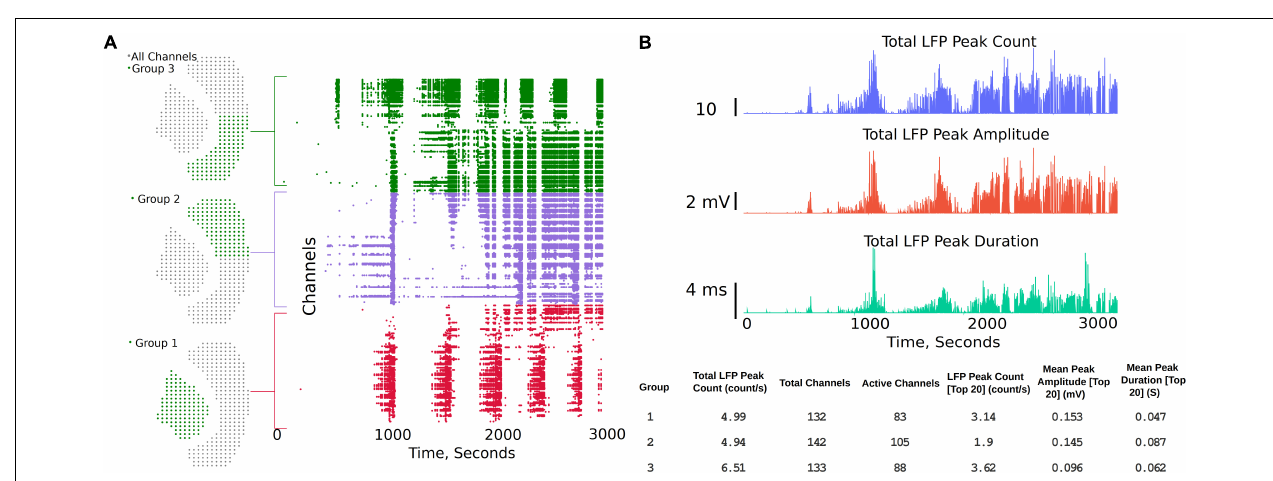
FIGURE 4 | Channel groups and raster plot can be generated to visualize LFP activity in different regions of the brain slice. (A) Sensor locations corresponding to three different regions selected for analysis and the region-specific raster plots. Group 1 being the hippocampus, while groups 2 and 3 each being one half of the Neocortex. (B) Summary plots and measures that can be generated within the analysis platform.